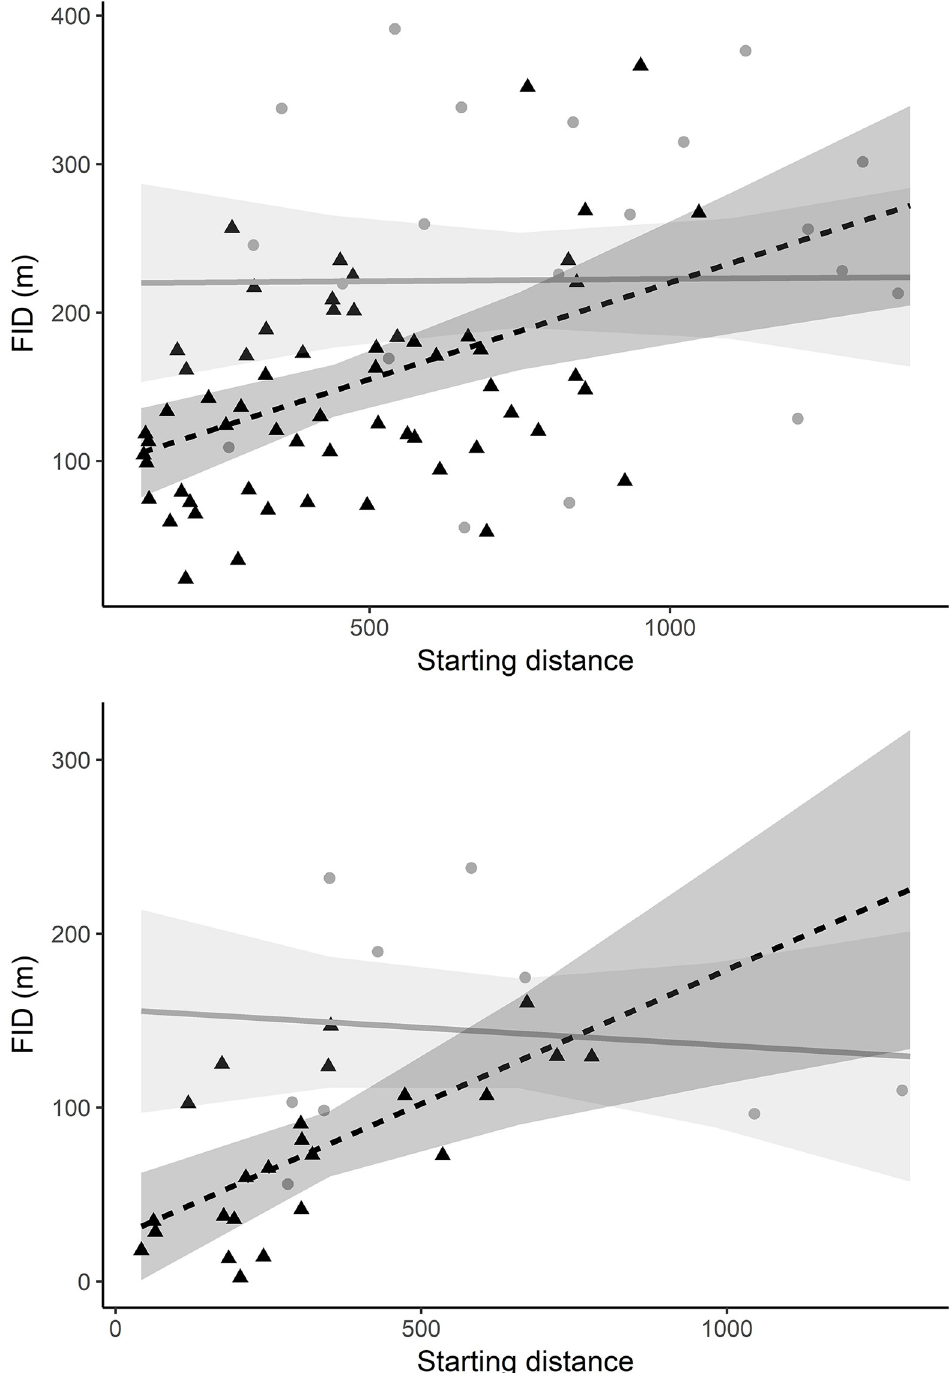
Fig 3. The predicted flight initiation distance (FID) of common goldeneyes (top) and mallards (bottom) in relation to the interaction of water body type and starting distance in southeast Norway in 2015 and 2016. Solid grey lines represent the predicted FID on lakes and dashed black lines the predicted FID on rivers. Raw data is shown with grey dots on lakes, and with black triangles on rivers. Grey shading represents 95% confidence intervals.